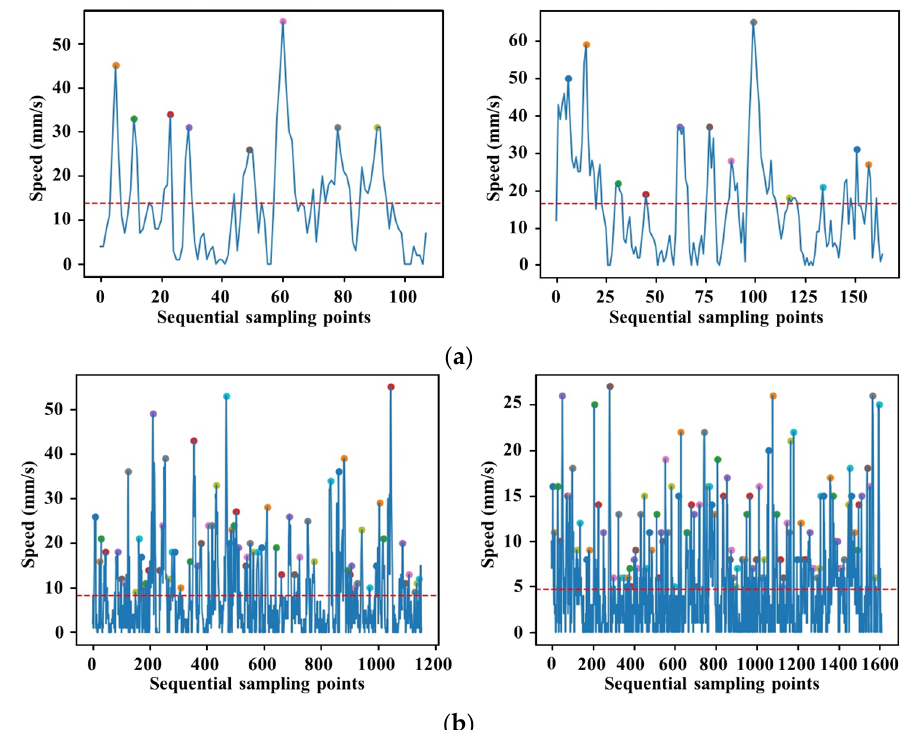
Figure 5. The detected speed peaks during two intravascular tasks performed by ( a ) an expert surgeon and ( b ) a novice surgeon, respectively.